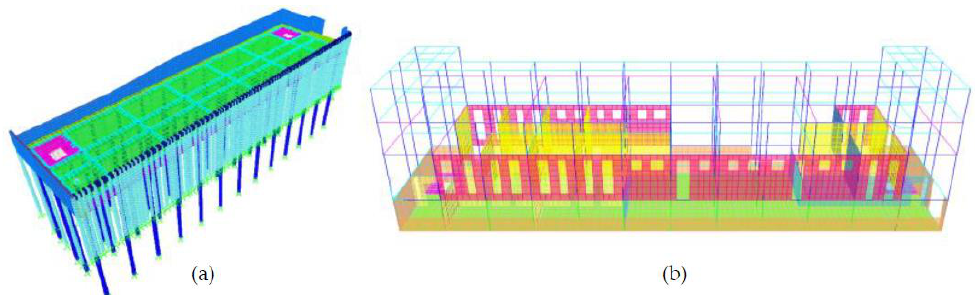
Figure 7. Modelling details: ( a ) foundation system, ( b ) infill walls of the first elevation.